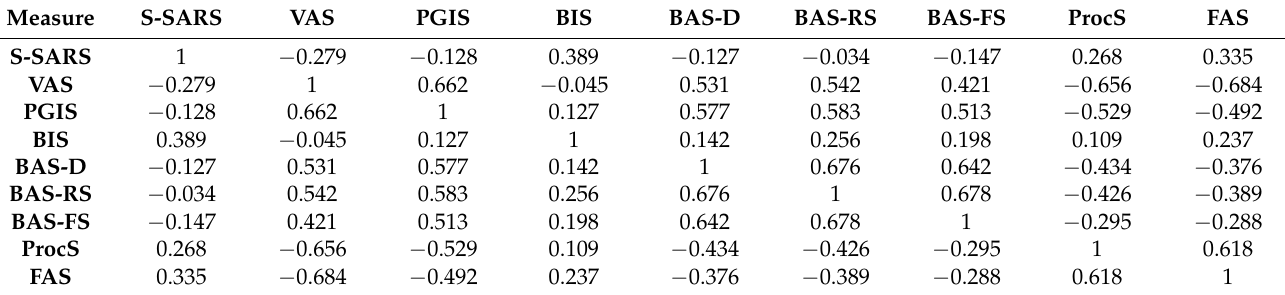
Table 8. Pearson’s correlation coefficients among the measures only in data set no